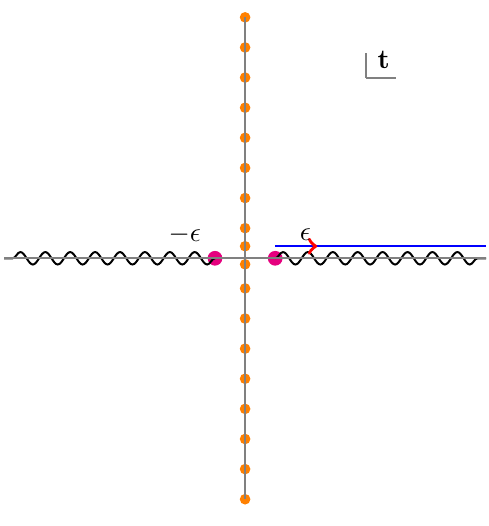
Figure 1 . Integration contour in u -plane.